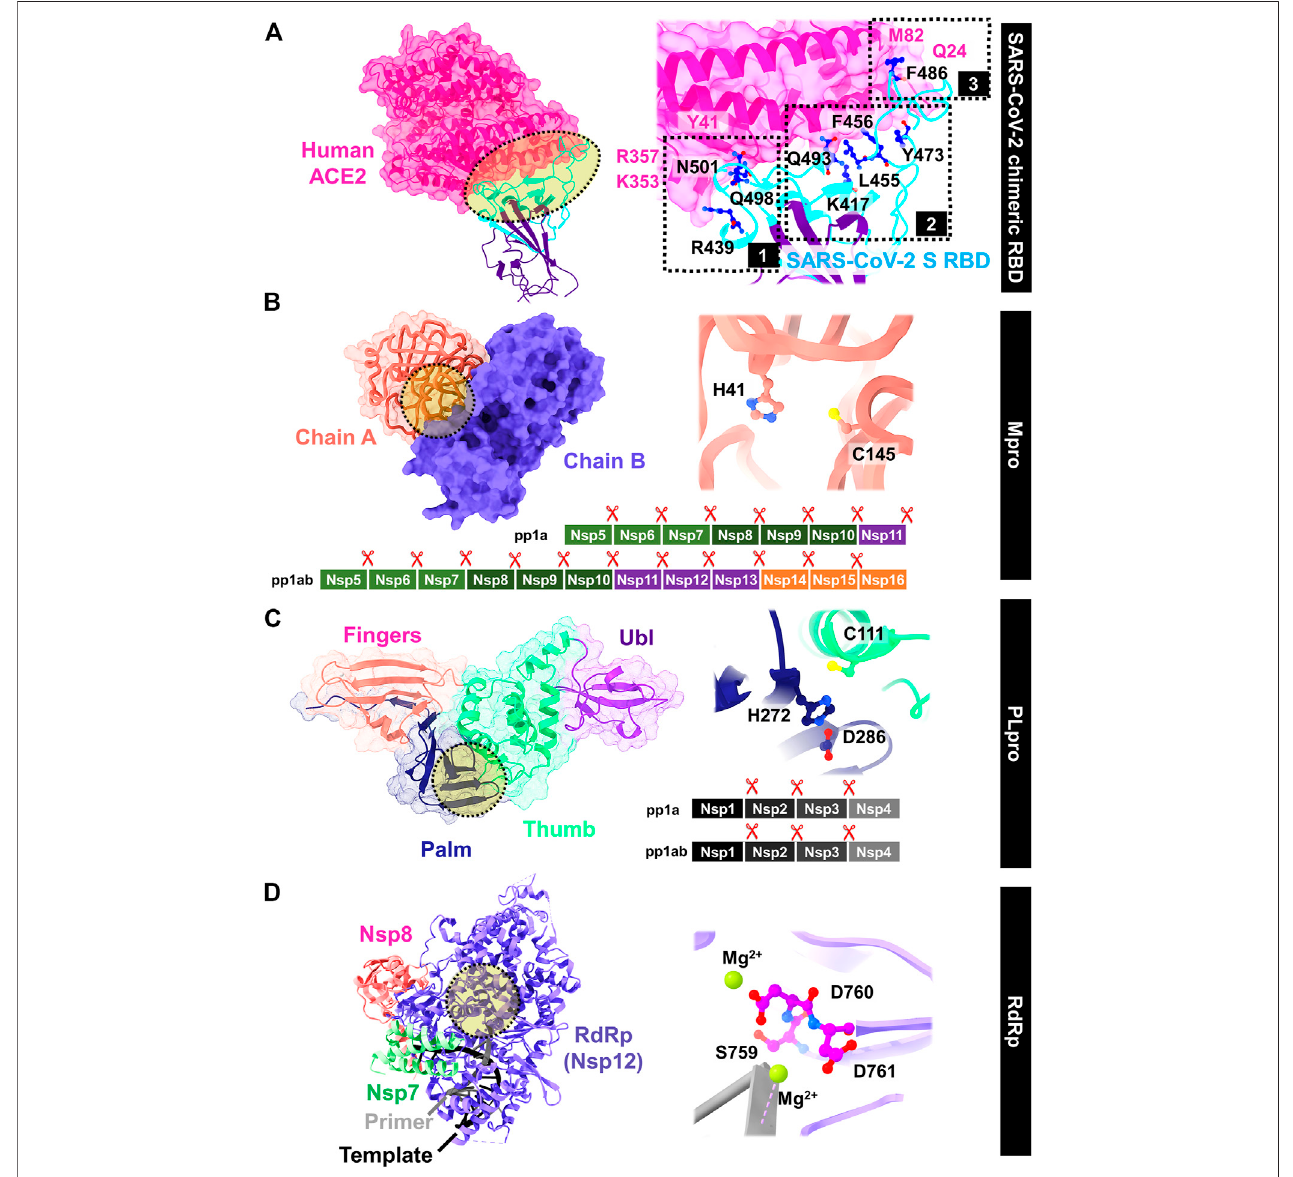
FIGURE 5 | Viral targets for drug development against SARS-CoV-2: (A) S RBD/ACE2 binding, (B) Mpro, (C) PLpro, and (D) RdRp, whereas the important residues are also labeled.